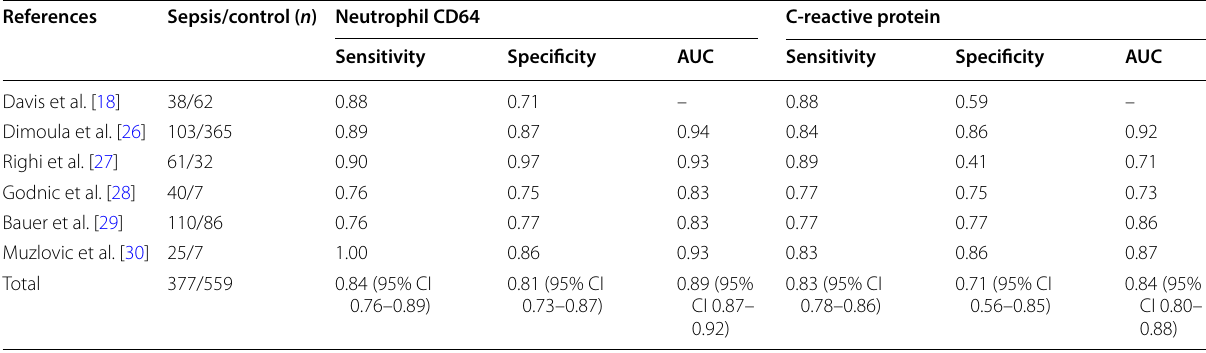
AUC area under the receiver operating characteristic curve, Table 5 Results from individual studies of neutrophil CD64 and procalcitonin as markers for the diagnosis of sepsis